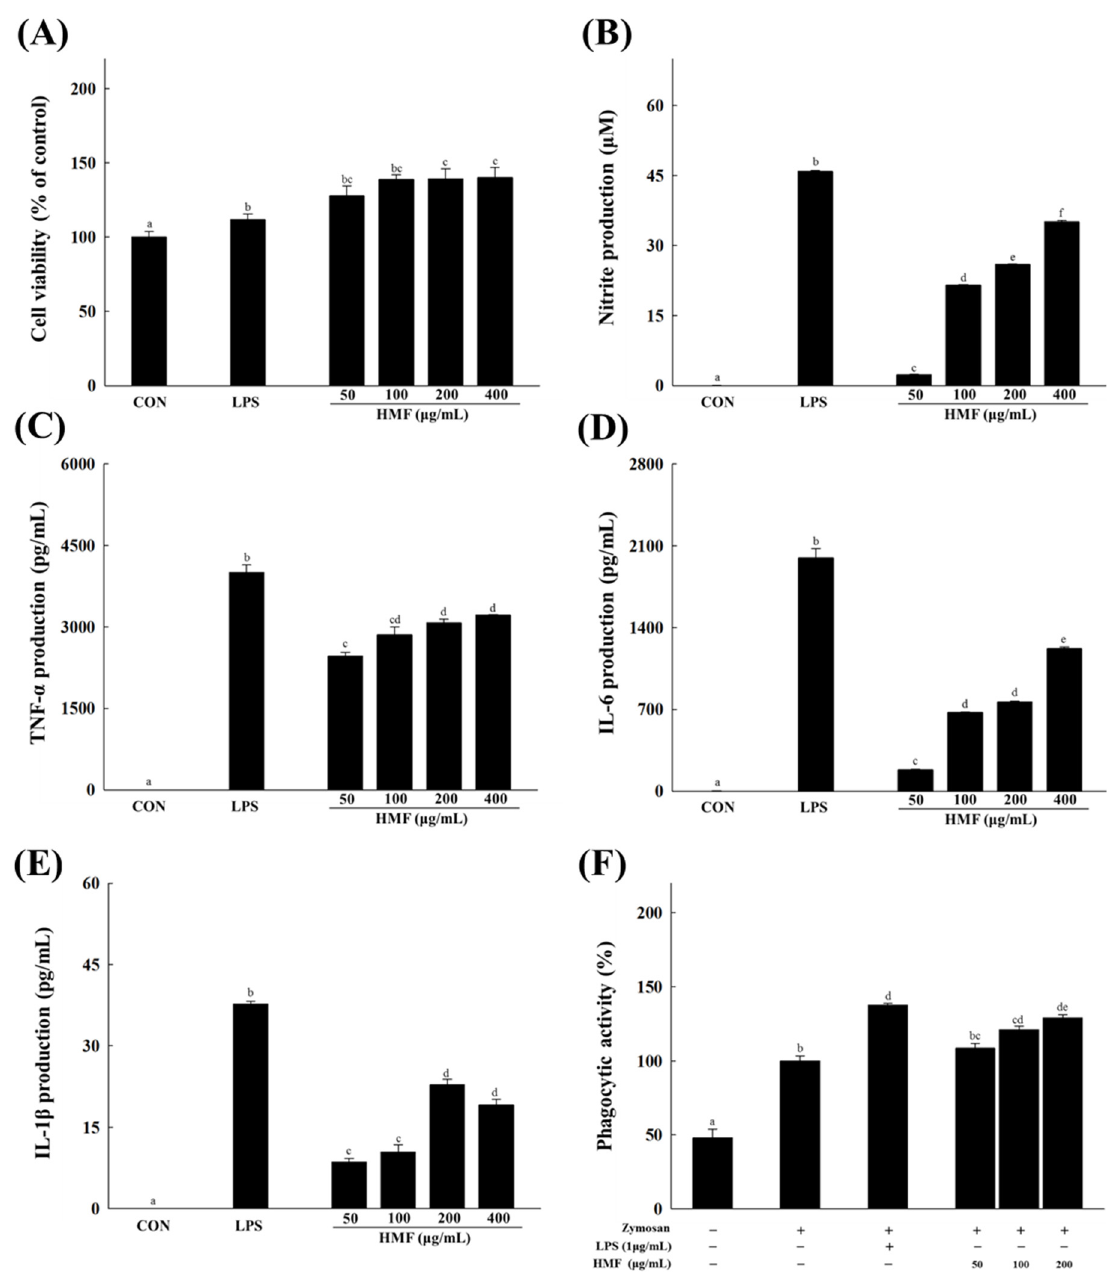
Figure 1. Effects of a high molecular weight fraction (HMF) of Cynanchum wilfordii on nitric oxide (NO), tumor necrosis factor alpha (TNF- α ), interleukin (IL)-6, and IL-1 β production, and phagocytic activity in macrophages. RAW 264.7 macrophages were stimulated with the HMF (50, 100, 200, or 400 µ g/mL) or with lipopolysaccharide (LPS; 1 µ g/mL). LPS was used as the positive control. ( A ) Cell viability was determined by cell counting kit (CCK)-8 assay; ( B ) NO production was determined by measuring nitrite accumulation in culture medium. The productions of ( C ) TNF- α ; ( D ) IL-6; and ( E ) IL-1 β were measured using enzyme-linked immunosorbent assays (ELISAs); ( F ) Phagocytic activity was determined using a phagocytosis assay. Values with the different letters are significantly different ( p <